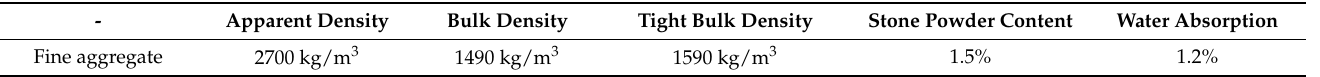
Table 2. The main properties of fine aggregate.